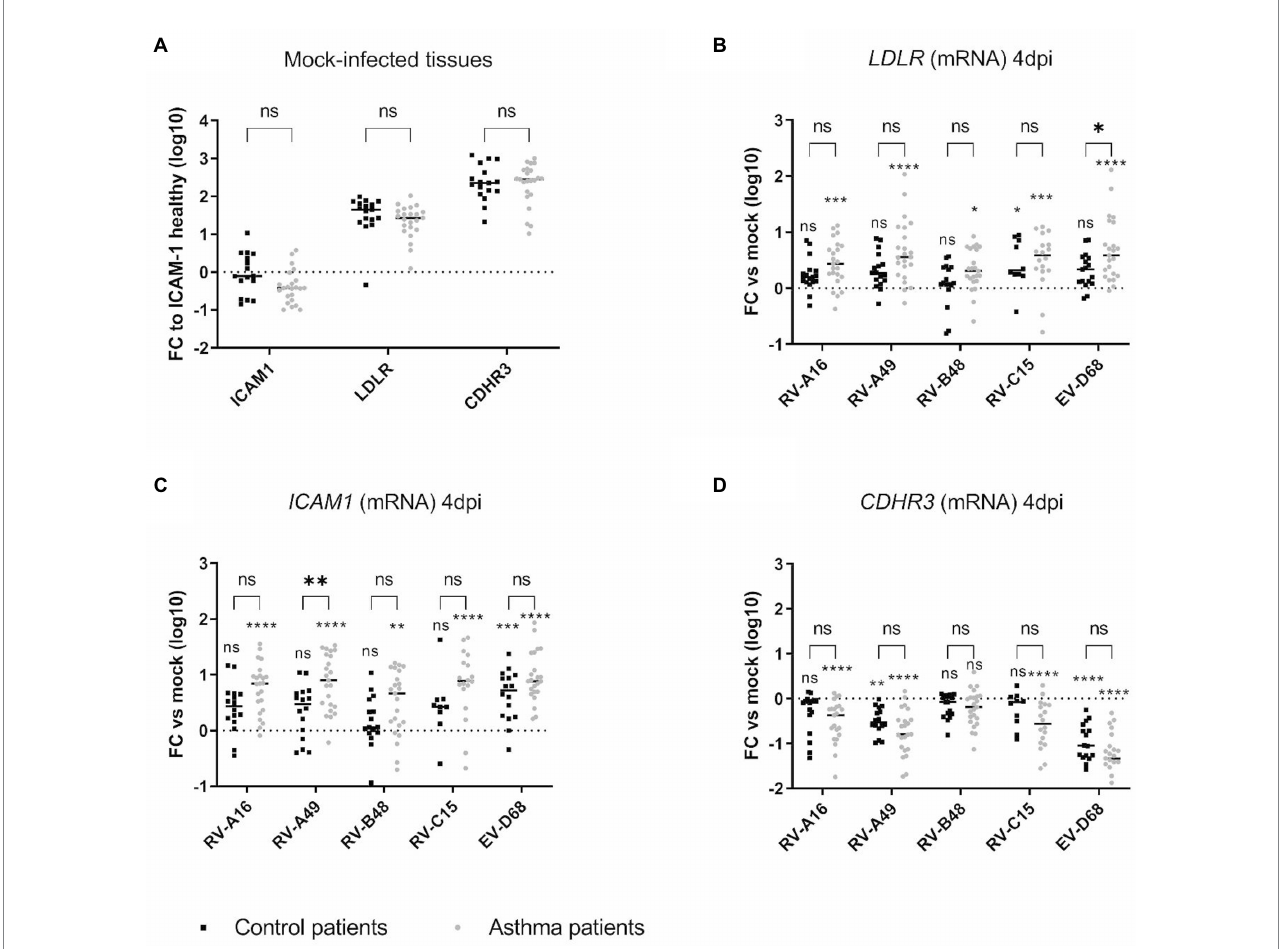
FIGURE 2 Expression of the different RV receptors in (A) mock-infected and in (B–D) infected tissues derived from asthmatic and control donors and measured by RT-sqPCR on total tissue lysates. In (A) the fold change (FC) is calculated relative to ICAM1 expression in tissues derived from control donors. In (B) , (C) , and (D) , the fold change of LDLR , ICAM1, and CDHR3 is calculated relative to expression in mock-infected tissues derived from donors within the same group (asthmatic or control). Eleven control and 12 asthmatic patients were included (Supplementary Table S1). The signs directly above each scatter plot indicate significance between mock-infected and infected tissues for each of the condition (asthma or control). The enlarged signs indicate significant differences between control and asthmatic donors. ns: non-significant, * p < 0.05, ** p < 0.01, *** p < 0.001, and **** p <